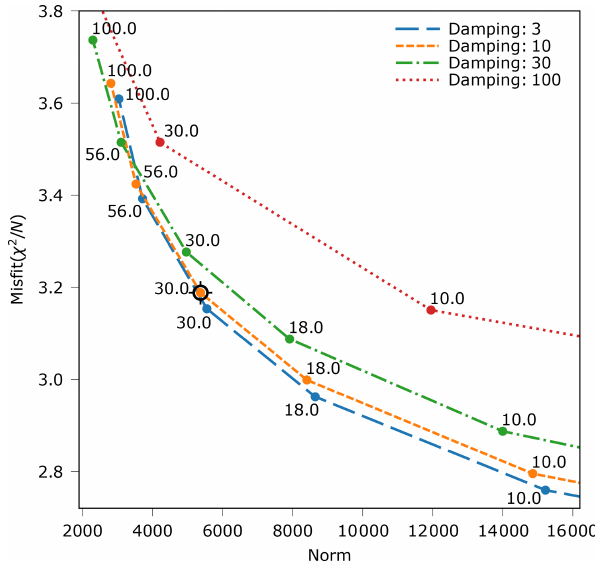
Figure 11. Data misfit against model norm for different smoothing and damping parameters. Different damping parameters indicated by line and point colours. Smoothing parameters are written as text besides data points in the plot.